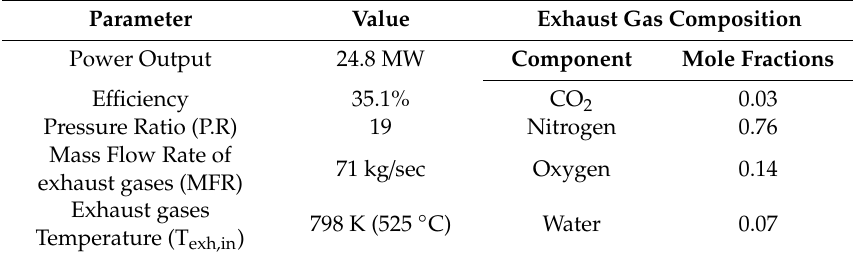
Table 2. Specification of GE-LM2500 topping gas turbine. Adapted from [26].